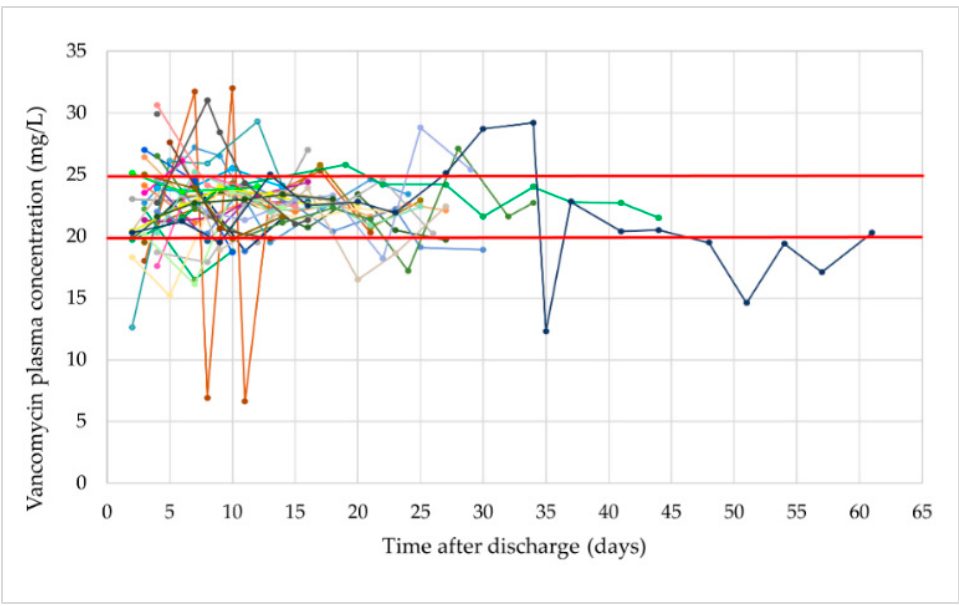
Figure 2. Vancomycin plasma concentrations measured during vOPAT per patient ( n = 203). Red lines: therapeutic range for vancomycin plasma concentrations when administered via continuous infusion (i.e. 20-25 mg/L).